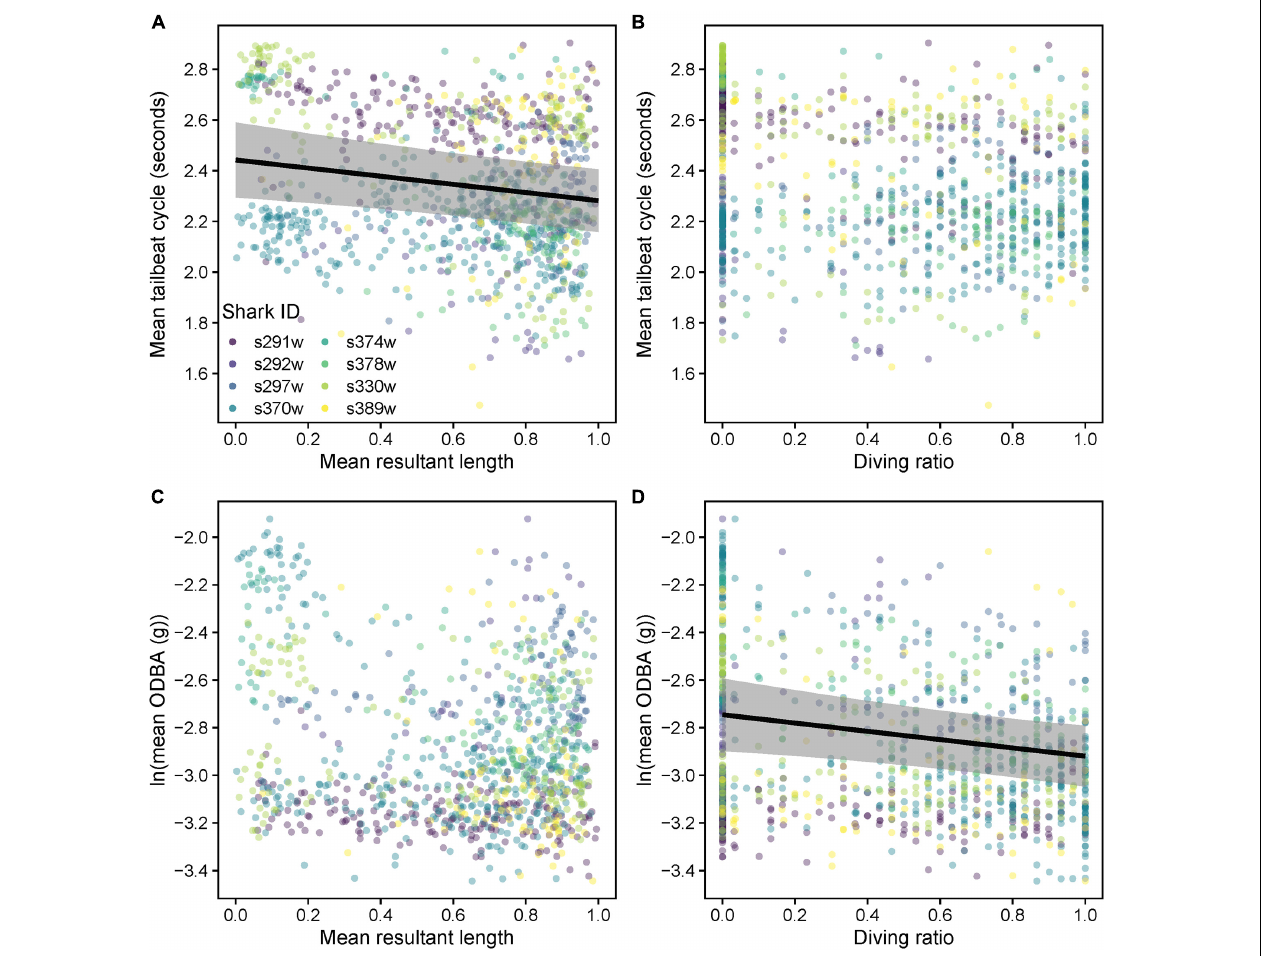
FIGURE 10 | Relationships between mean tailbeat cycle length (A) mean resultant length ( R ) and (B) diving ratio (DR), and between mean overall dynamic body acceleration (ODBA, natural log transformed) (C) R and (D) DR. Variables were computed over 15 min windows for each shark. Predicted relationships (gray shading = 95% confidence intervals) from a linear mixed model are shown where there was a significant effect ( p < 0.05).